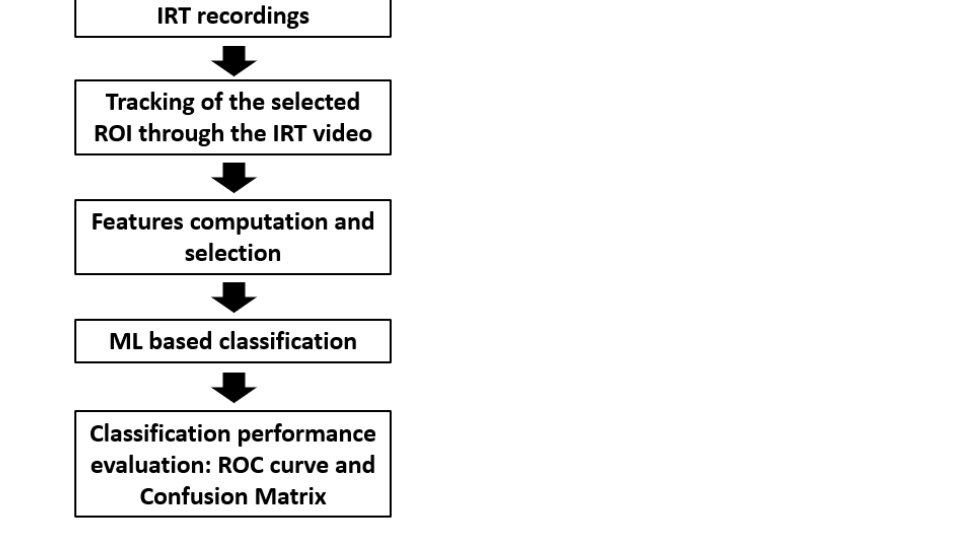
Figure 2. Flowchart describing the processing pipeline: data acquisition, processing, and ML-based classification.